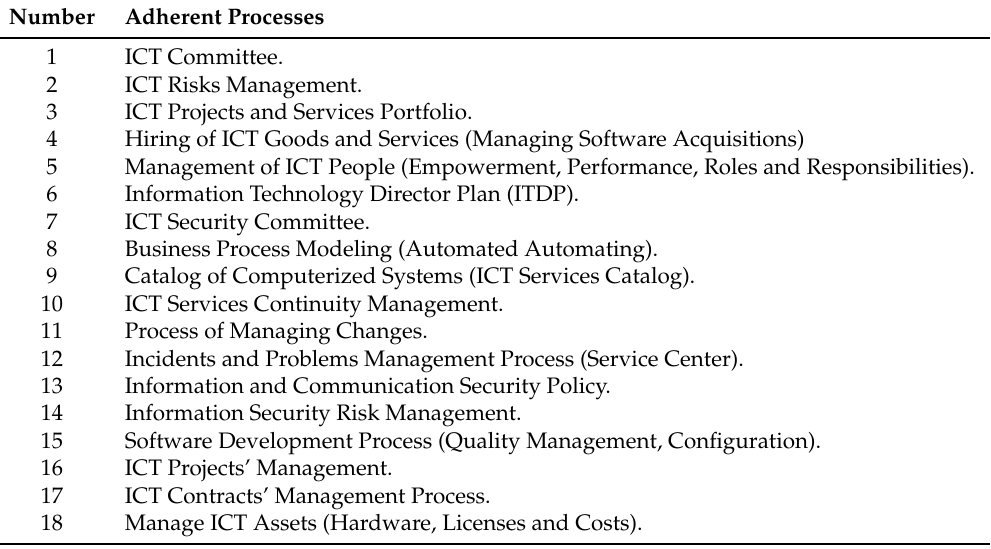
Table 1. State of the government processes for the elaboration of Governance